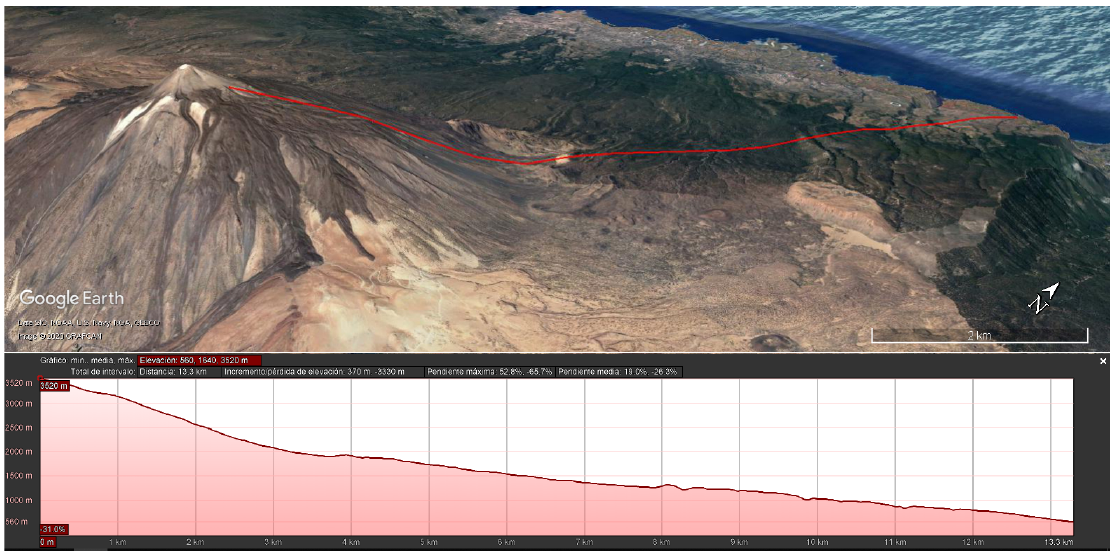
Figure 10. Location of the prototype node and the gateway, and their associated elevation profile. Images taken from Google Earth c (cid:13)